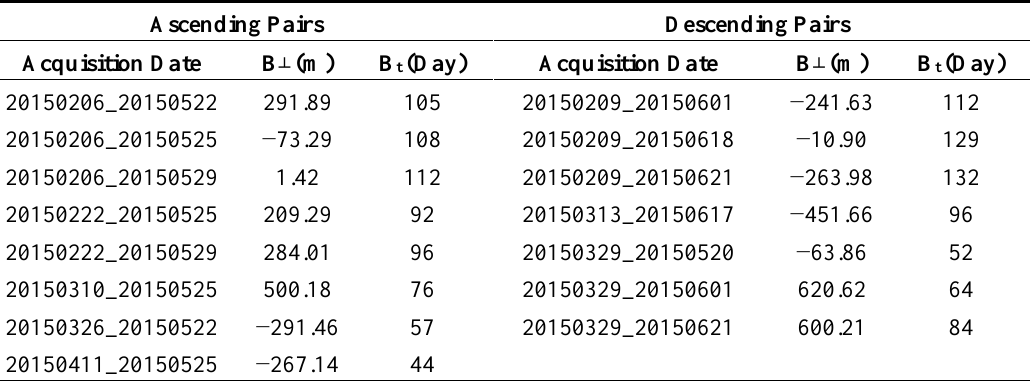
Table 1. Co-eruptive interferometric pairs of COSMO-SkyMed ascending and descending data sets used in this